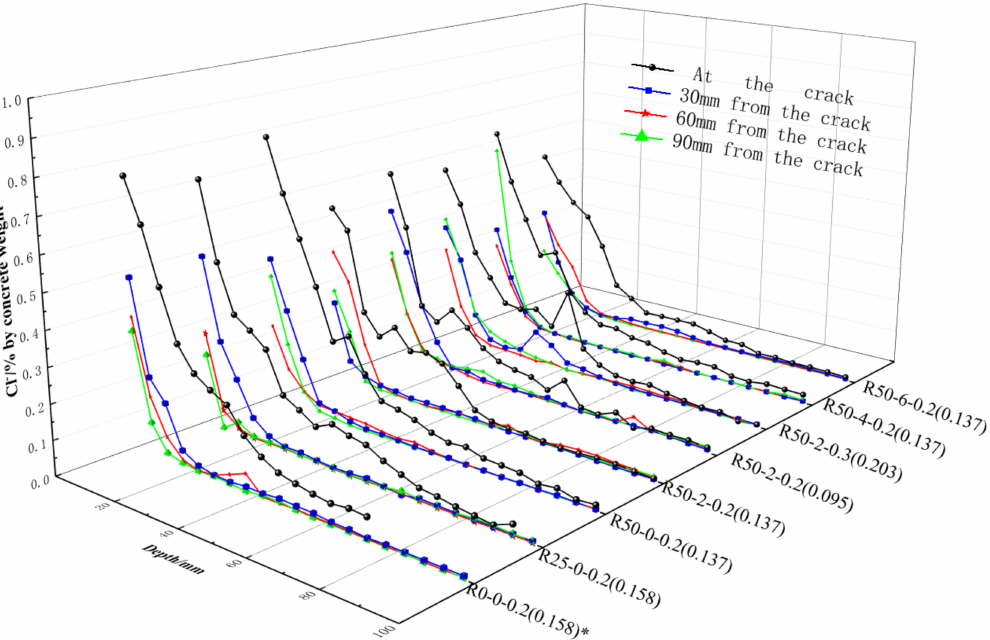
Figure 13. Distribution of chloride ion contents at different depths as a function of distance. Note (*): the values in brackets refer to the actual widths of the cracks selected in the specified